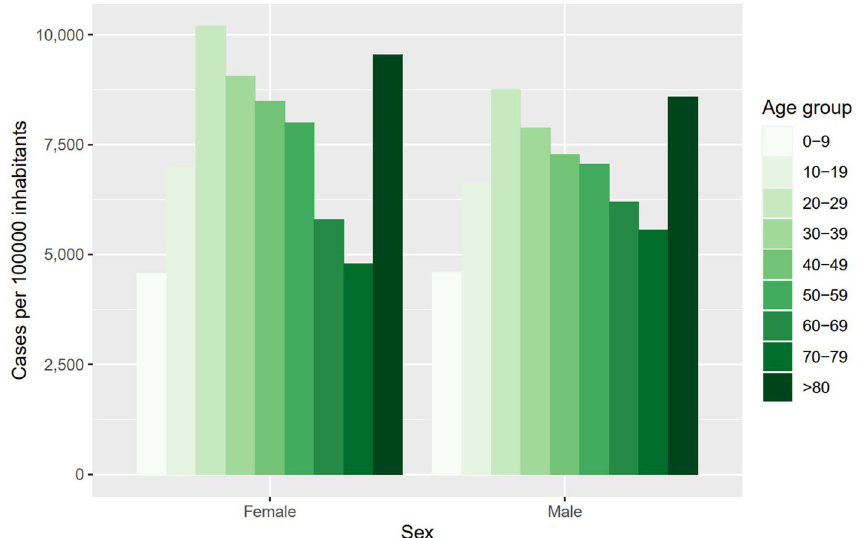
Figure 9. COVID-19 cases per 100,000 inhabitants during the study period, distributed per sex and age